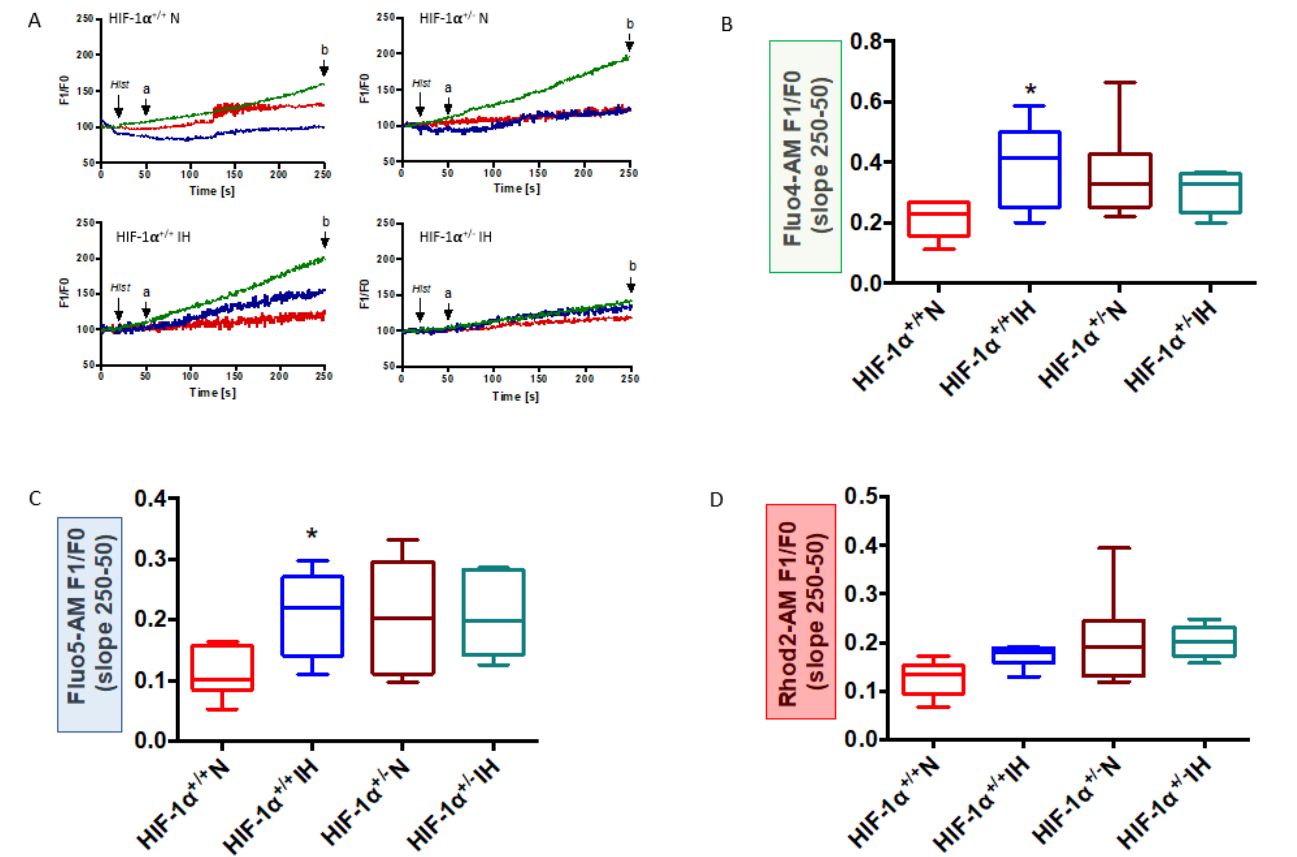
Figure 5. IH-induced Ca 2+ homeostasis alteration is mediated by HIF-1. Mitochondrial-associated ER membrane calcium fluxes between ER and mitochondria in HIF-1 α +/+ and HIF-1 α +/ − mice submitted to normoxia (N) or chronic intermittent hypoxia (IH). Illustration of calcium fluorescence after histamine-induced ER-calcium leakage using Fluo 4-AM (cytosol, green), Fluo 5-AM (ER, blue) and Rhod 2 (mitochondria, red) recorded between 50 (a) and 250 (b) seconds after ( A ), n = 7–8. Quantification of fluorescence F1 relative to F0 recorded in cytosol ( B ), ER ( C ), and mitochondria ( D ). Data were expressed in median and min to max values and analyzed using Kruskal–Wallis followed by Dunn’s test; * p < 0.05 vs. N.